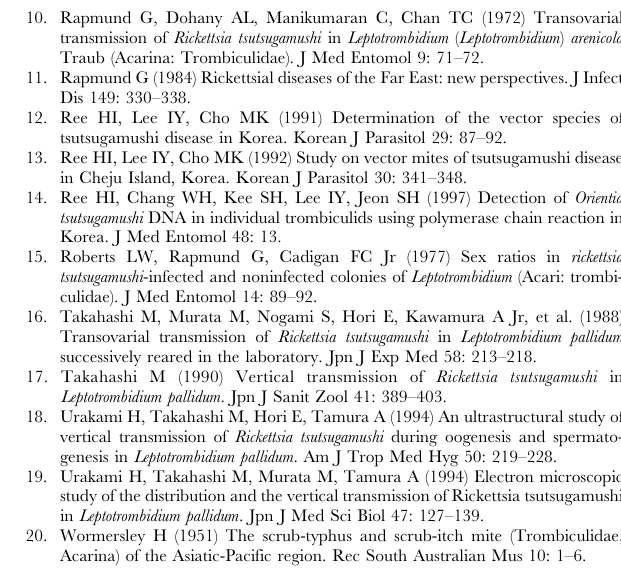
Infected/Uninfected